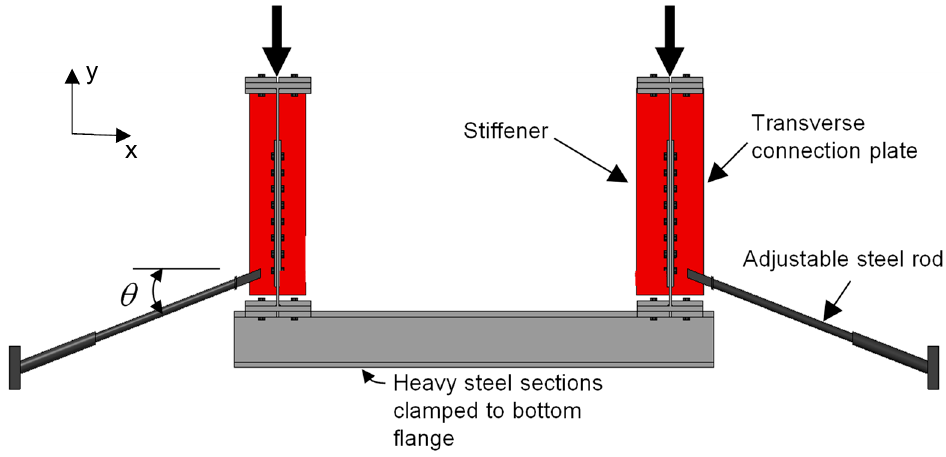
Figure 7. Fatigue test of distortion-induced fatigue sensitive detail: section (units: millimetres).